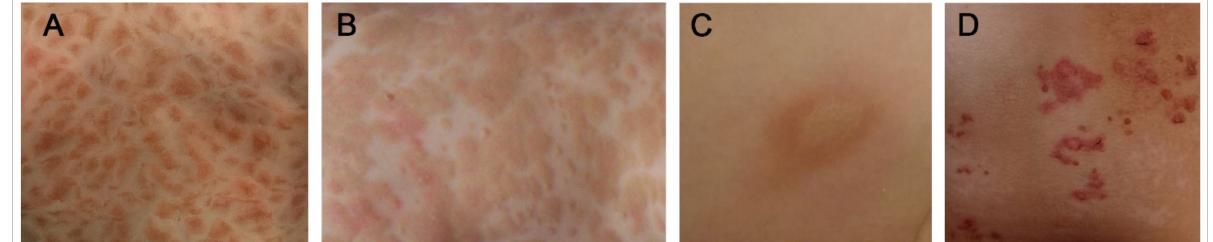
Figure 1. Cutaneous manifestations in Patients with Pediatric Mastocytosis. ( A ) Maculopapular cutaneous mastocytosis— monomorphic variant. ( B ) Maculopapular cutaneous mastocytosis—polymorphic variant. ( C ) Mastocytoma. ( D ) Diffuse cutaneous